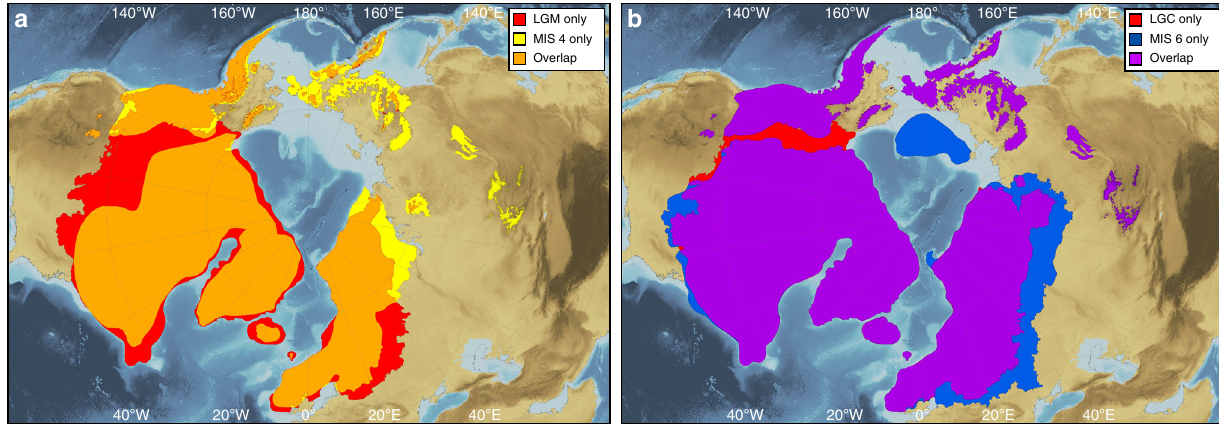
Fig. 3 Comparison of NH ice-sheet extent during the last glacial cycle and MIS 6. a shows a comparison of the reconstructed ice-sheet extent during the LGM and MIS 4. The orange fi ll shows areas that were covered by ice sheets during both the LGM and MIS 4. b shows a comparison of the reconstructed geographical maximum ice-sheet extent during the last glacial cycle (MIS 2 – 5d) and MIS 6. The purple fi ll shows areas that were covered by ice sheets during both the last glacial cycle (LGC) and MIS 6. Background is ETOPO1 1 arc-minute global relief model of the Earth ’ s surface 72